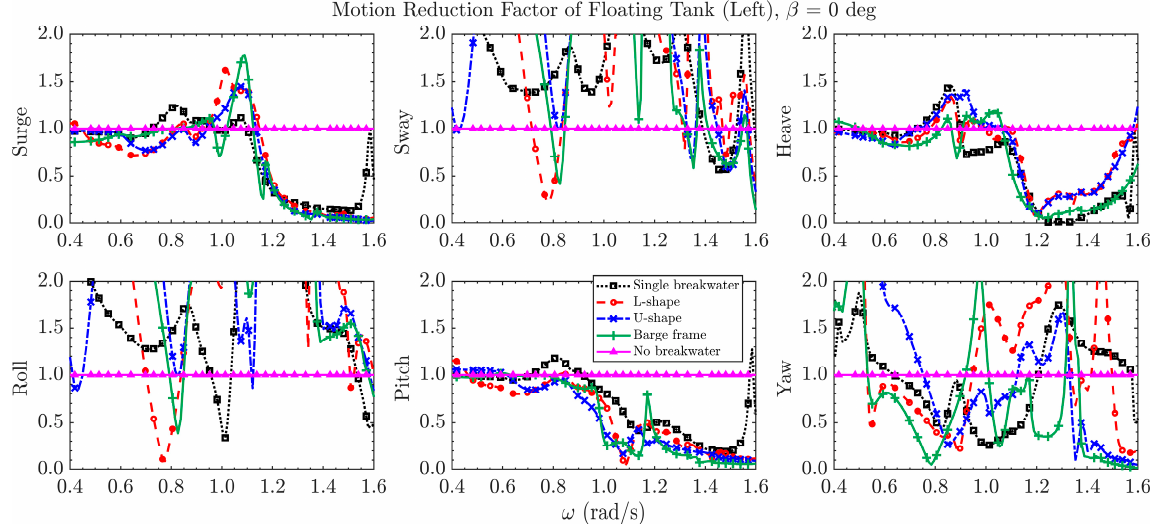
Figure 14. Effectiveness of the floating breakwater in motion reduction of the floating tanks in 0 deg incident wave direction .